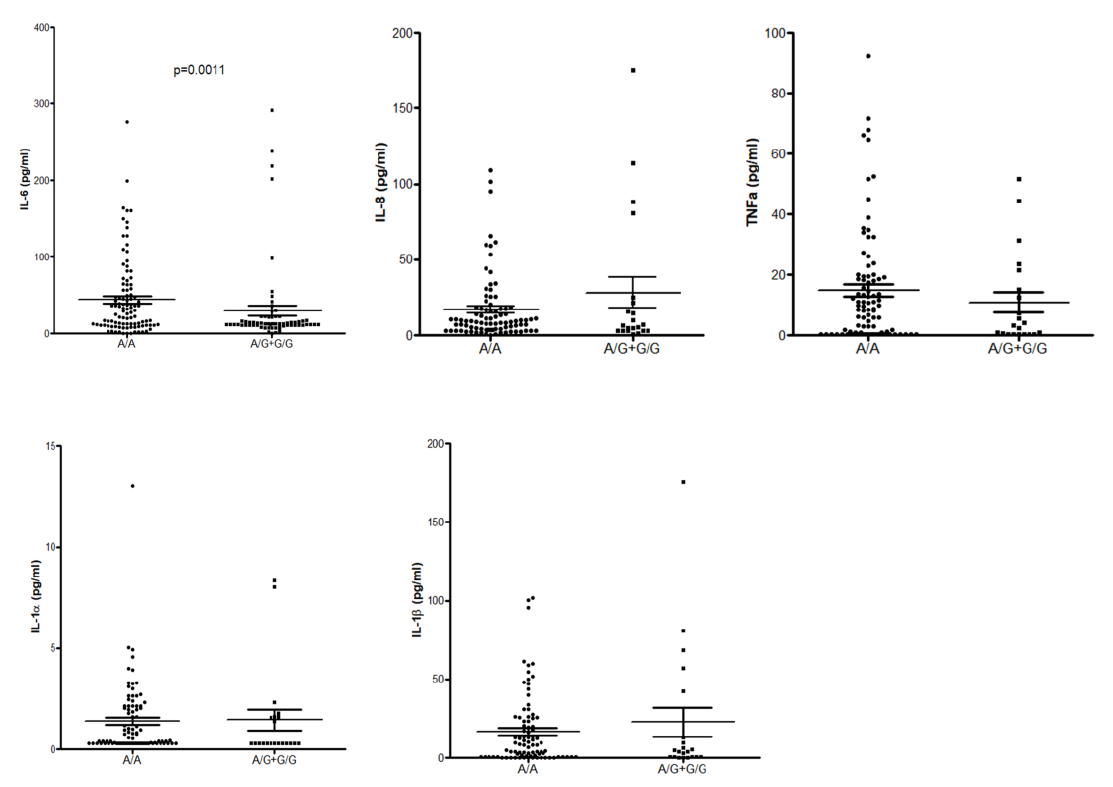
Figure 5. Effect of the TLR5 rs2072493_G/A (N592S) genotypes on serum IL-6, IL-8, TNF α , IL-1 α , and IL-1 β concentrations. Analysis was performed with a ProcartaPlex High Sensitivity Assay, according to manufactures protocol, which can be found in the Materials and Methods section. Statis- tical analysis was performed by using GraphPad; non-parametric t -test (Mann – Whitney test). Dots represent A/A genotype, squares represent A/G + G/G genotype.